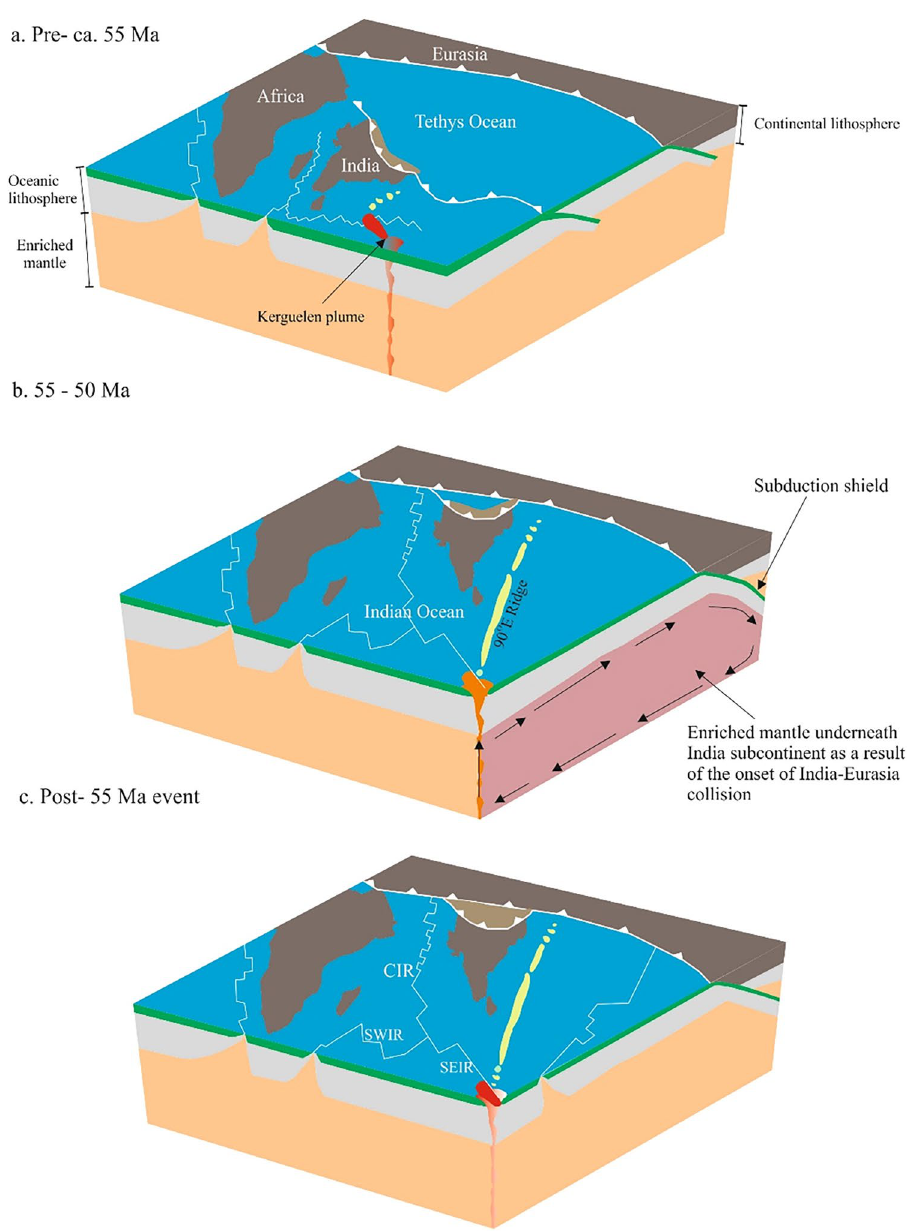
Figure 6. MOR–plume interaction cycles. ( a ) MOR–plume coupling, slightly enriched mantle related to identical interaction between the KMP and the SEIR produced E-MORBs. ( b ) Decoupling of MOR–plume at ca. 55 Ma; the onset of India–Eurasia collision led to continental materials recycling into the mantle. ( c ) Recoupling of MOR–plume postdates India–Eurasia